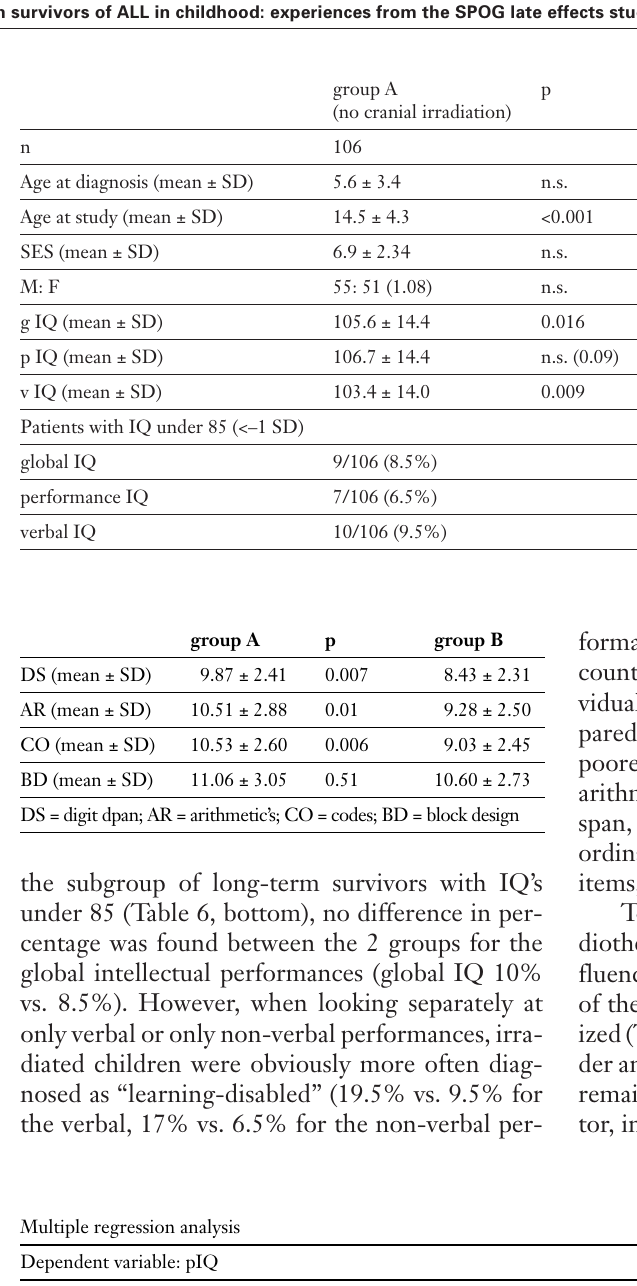
Impact of cranial radiotherapy, gender and length of follow- up: multivariate